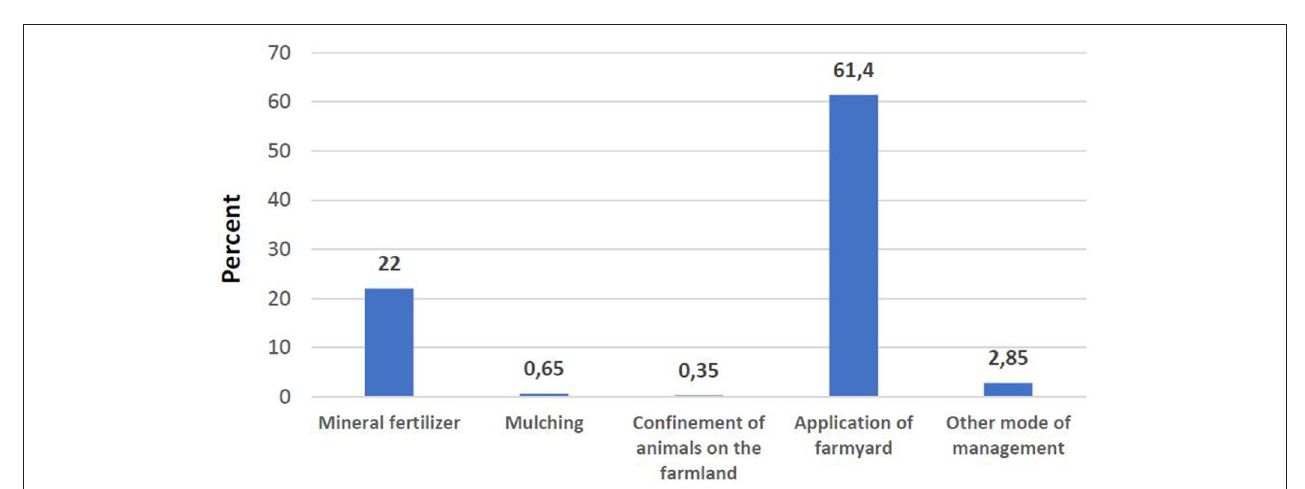
FIGURE 4 | Farmers’ soil fertility management